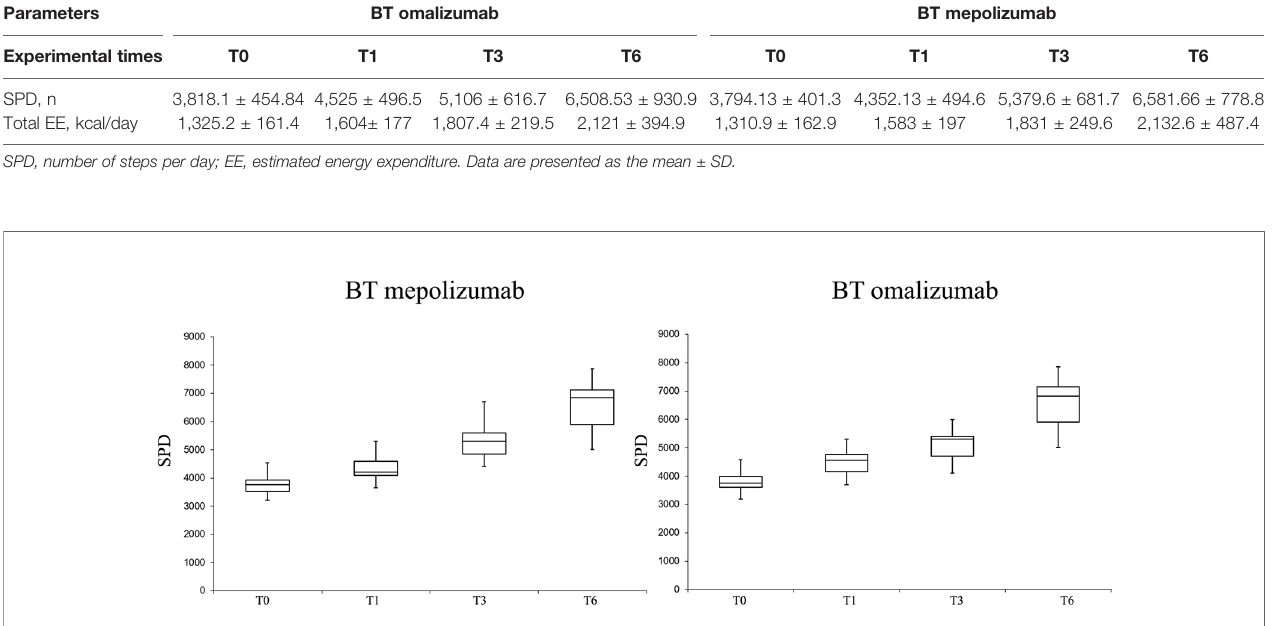
TABLE 3 | Physical activity at T0, T1, T3, and T6 in biologic therapy (BT) omalizumab and BT mepolizumab groups. Parameters BT omalizumab BT mepolizumab Experimental times